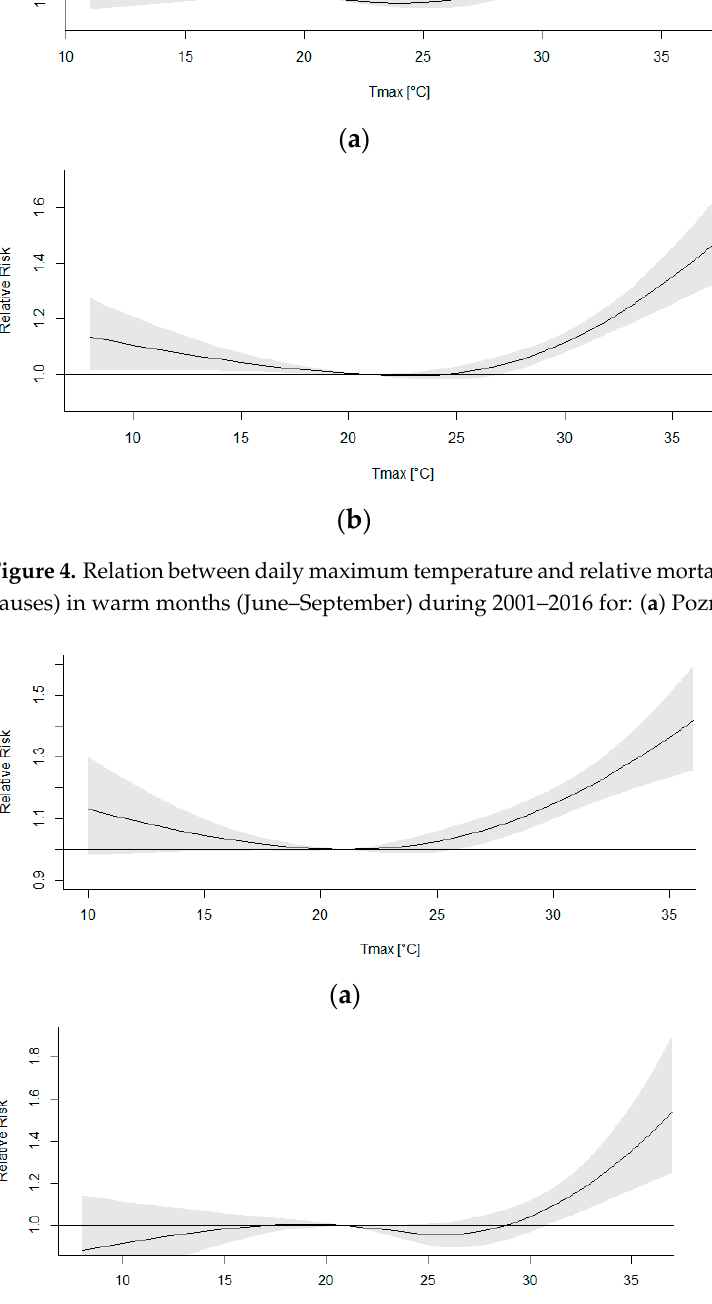
( a ) ( b ) Figure 6. Relation between daily maximum temperature and relative mortality risk (all non-acci- dental causes) in warm months (June–September) for towns with population of 25–50 thousand during 2001–2016: ( a ) Wielkopolska; ( b ) Ma ł opolska. ( a )